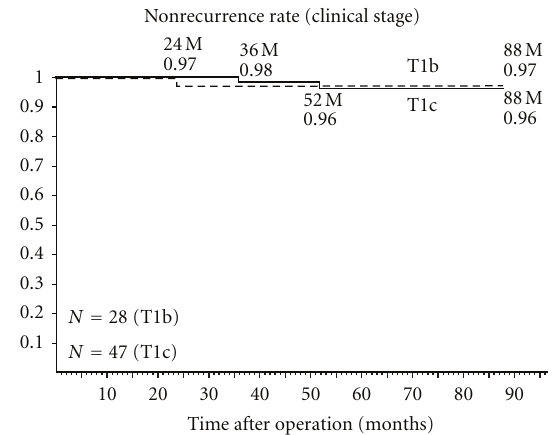
Figure 1: Actuarial biochemical non-recurrence rate of each clinical stage.